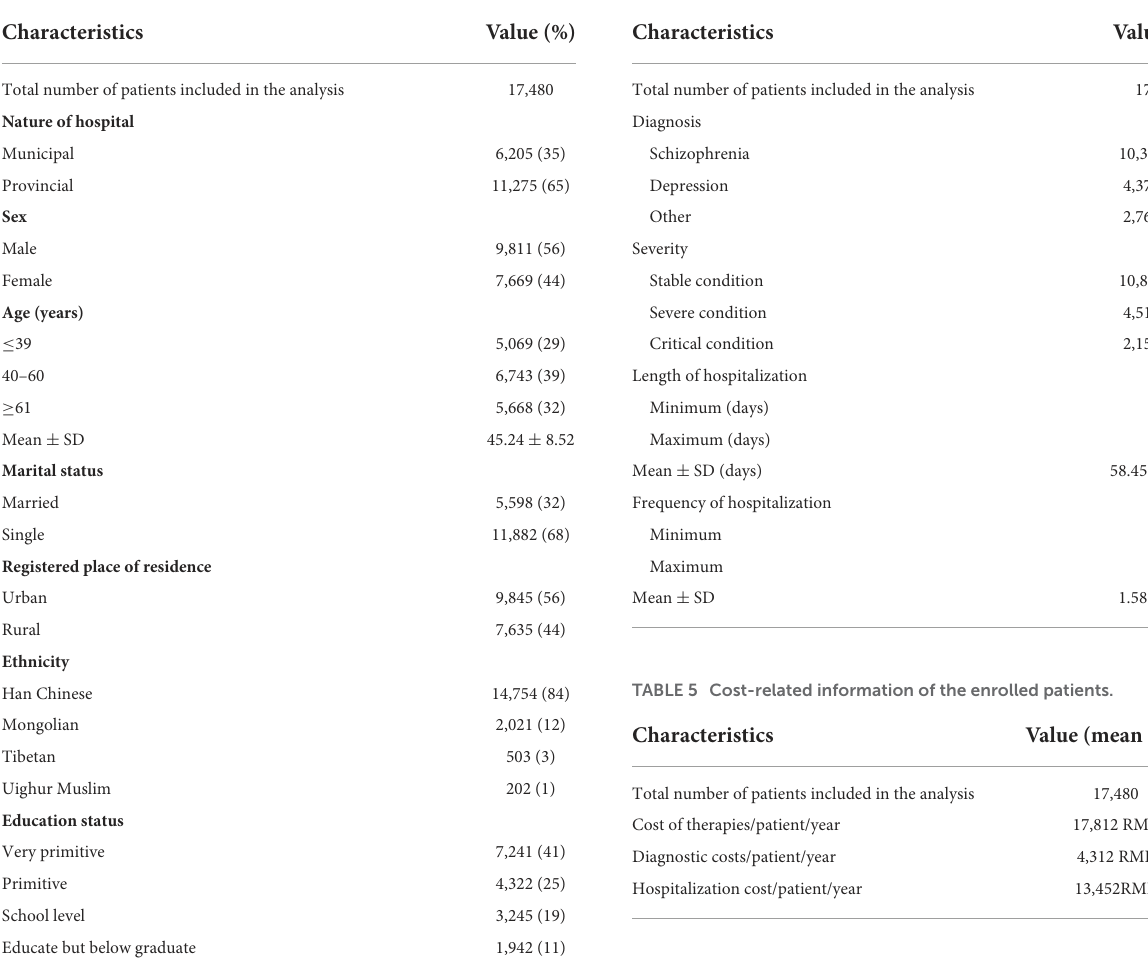
TABLE 3 Sociodemographic characteristics of enrolled patients. TABLE 4 Clinical characteristics of the enrolled patients.